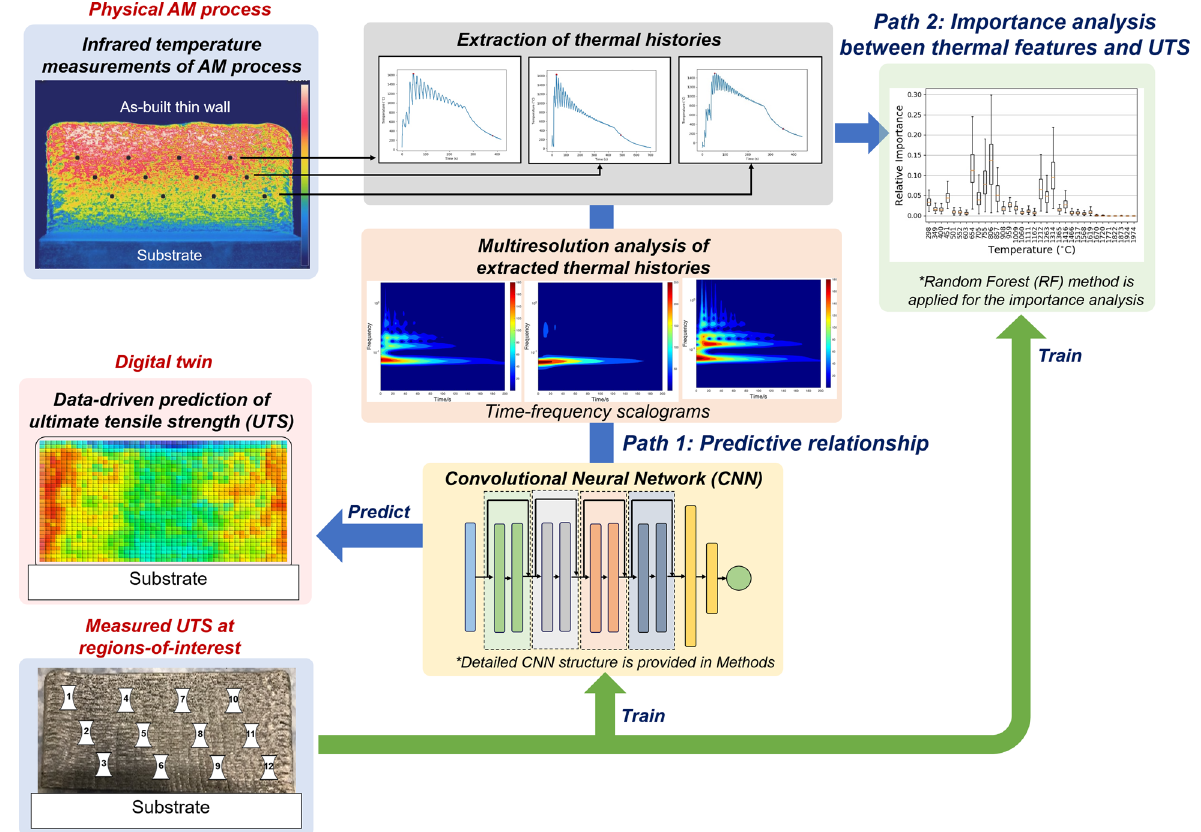
Fig. 1 A schematic of the proposed mechanistic data-driven framework. The proposed framework includes two modeling paths for different objectives but share the same experimental data. The path 1 is designed to correlate and predict mechanical properties based on process-induced thermal histories. It links thermal histories, multiresolution analysis based on wavelet transforms, a convolutional neural network (CNN), and ultimate tensile strength (UTS) predictions. The path 2 is designed to identify dominant mechanistic features from the dataset. It links thermal histories, importance analysis of thermal features, and UTS at